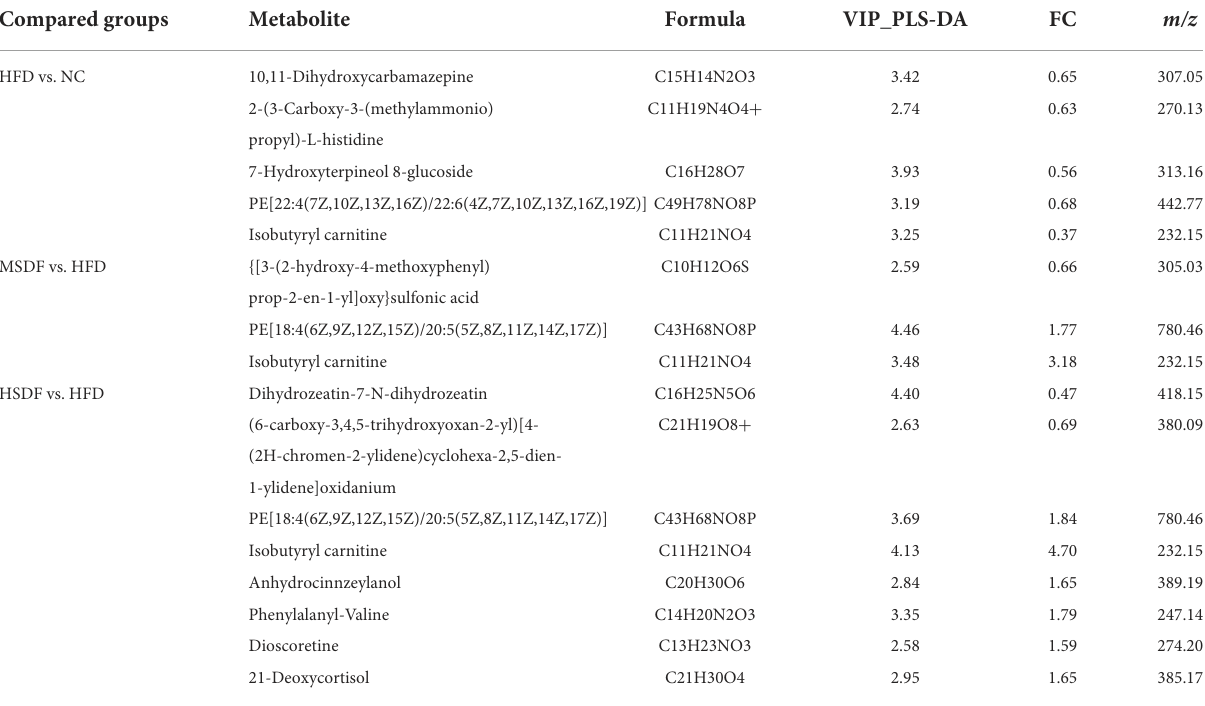
TABLE 2 Identification of different metabolites from each group of NC, HFD, MSDF, and HSDF. Compared